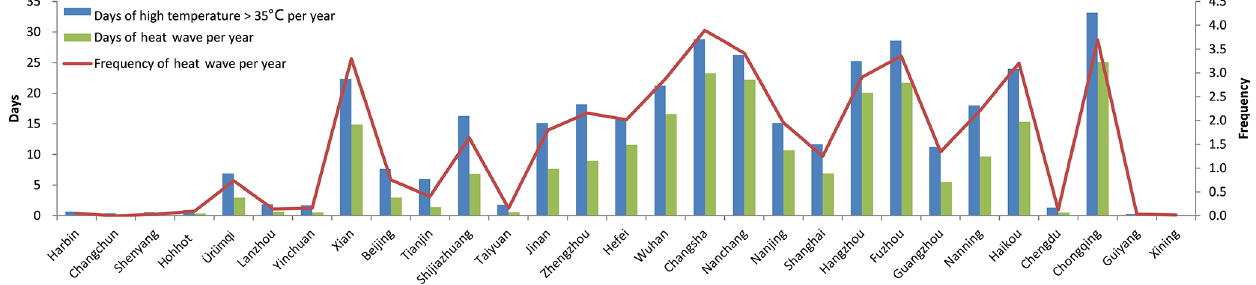
Figure 5. Comparison between D 35 and HWs per year in 29 cities of China from 1955 to 2014. There has been no high-temperature weather in which daily T max exceeds 35 ◦ in Kunming and Lhasa cities in the past 60 years. Therefore there are 29 cities shown in this